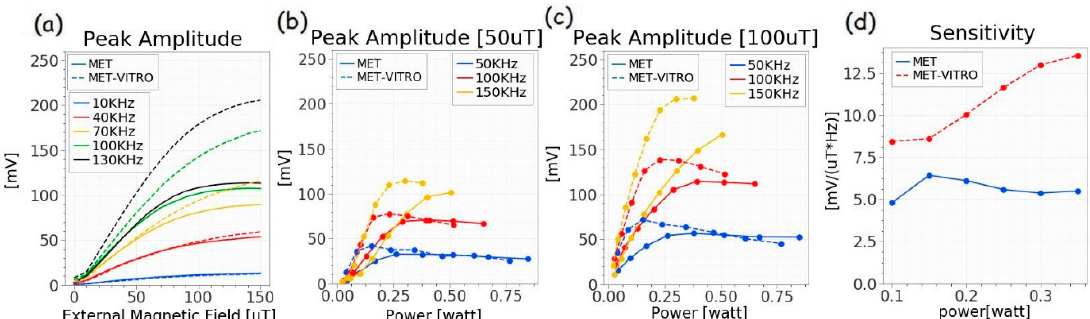
Figure 4. Experimental results: ( a ) Peak amplitude as a function of the magnetic field. ( b , c ) Peak amplitude as a function of supply power. ( d ) Sensitivity as a function of supply